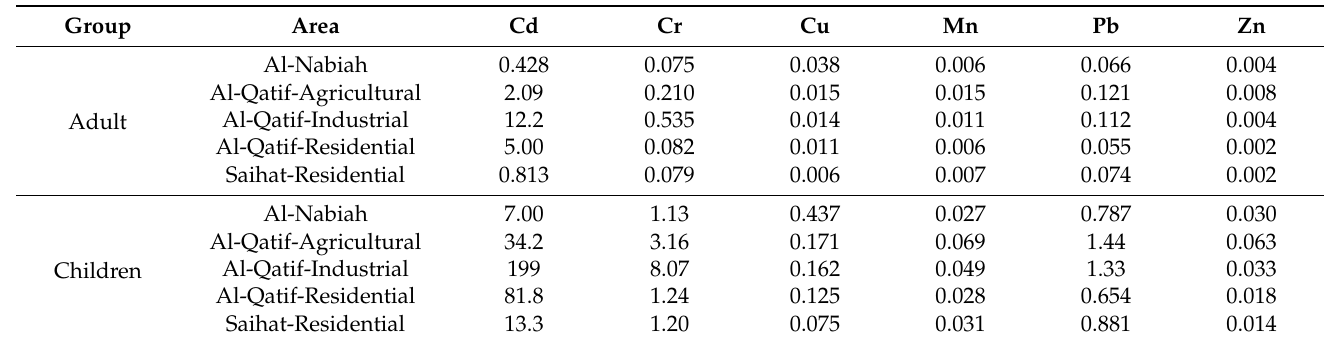
Table 4. Hazard index (HI) of the potentially toxic heavy metals in AC filters from different sam- pling sites.